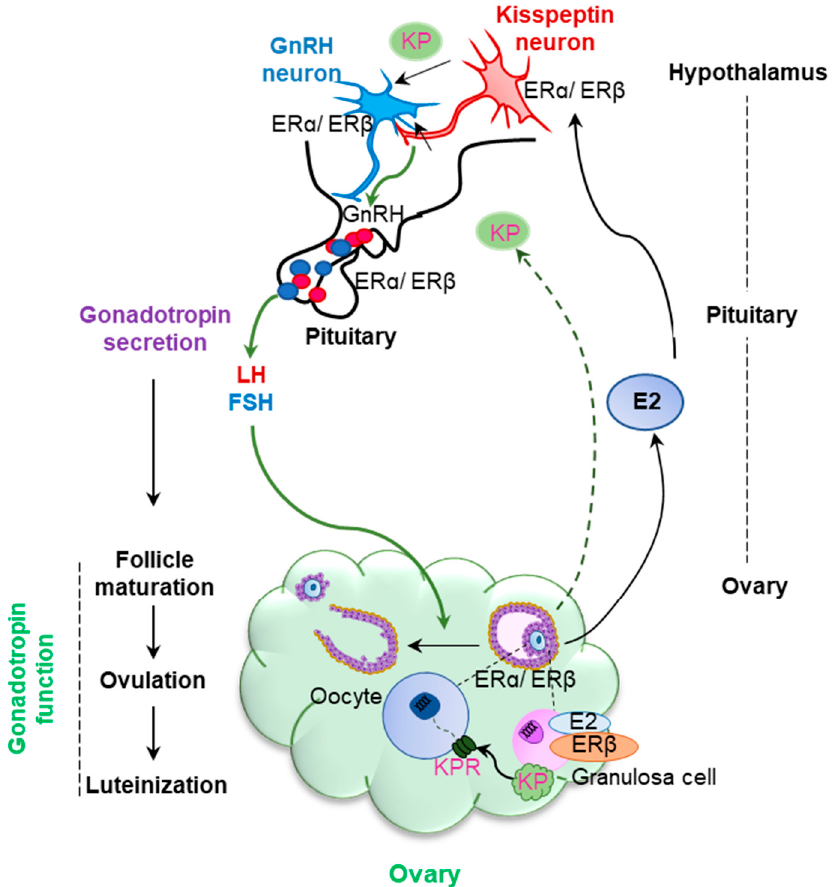
Figure 1. Estrogen receptor β (ER β ) regulation of gonadotropin production and function. Estradiol (E2) secreted from ovarian follicles acts on the kisspeptin (KP) neurons in the hypothalamus to regulate KP expression and release. KP acts on GnRH neurons to induce GnRH release in the hypothalamic–pituitary (H–P) axis. GnRH stimulates the gonadotrophs in the anterior pituitary to induce gonadotropin (FSH and LH) secretion. Gonadotropins act on the ovary to induce follicle development, oocyte maturation, ovulation, and luteinization. Estrogen receptors ER α and ER β are expressed in hypothalamic neurons, as well as in gonadotrophs. While ER α plays a predominant role in KP neurons, ER β regulates GnRH release and secretion of gonadotropins. Moreover, ER β is the major estrogen receptor in ovarian follicles. Thus, ER β plays a vital role in the levels of gonadotropin production and gonadotropin function.